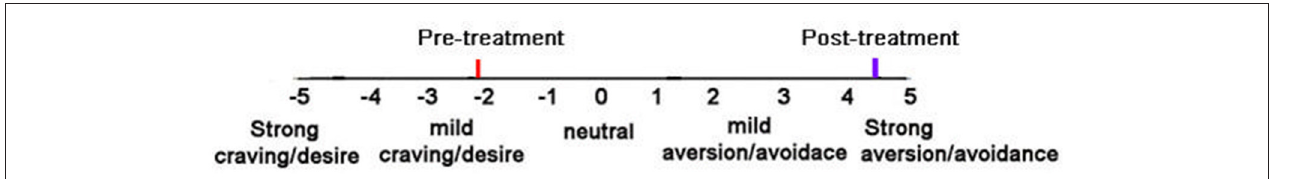
FIGURE 3 | Patients subjective ratings on the “craving/desire vs. aversion/avoidance” rating scale before treatment and after 4 aversion therapy sessions (post-treatment).